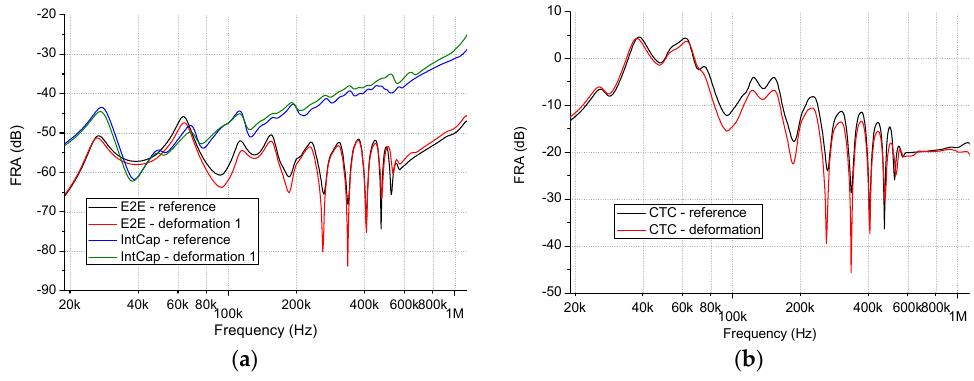
Figure 4. Laboratory transformer FRA test results for deformation 1 in MF range: ( a ) E2E and IntCap; ( b ) CTC.